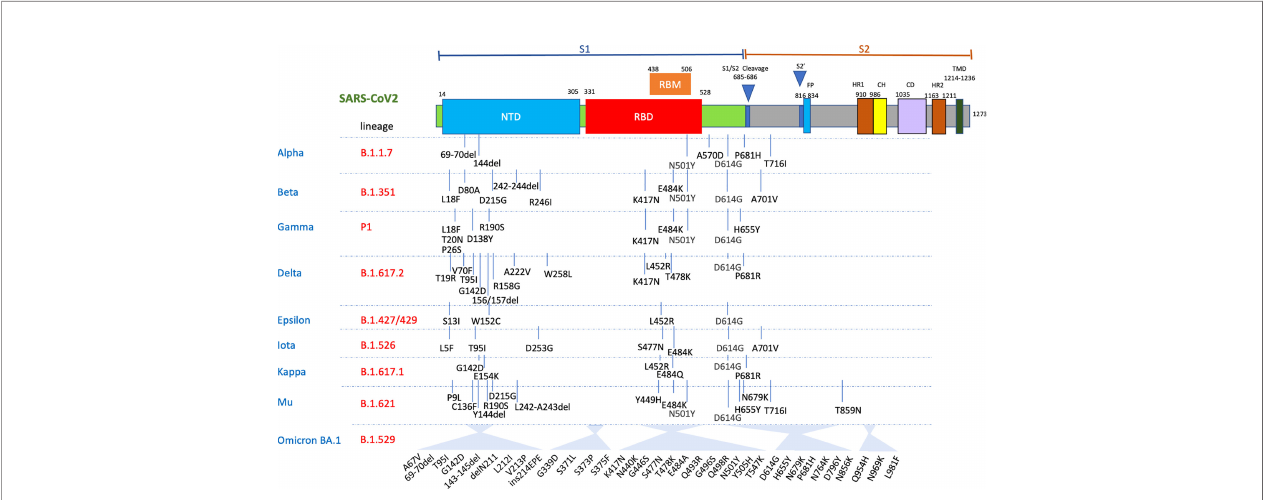
FIGURE 2 | Mutations in the viral spike identi fi ed in Alpha, Beta, Delta, Gamma, Mu and Omicron BA.1 SARS-CoV-2 variants showing the signi fi cant clusters of changes in both the N-terminal domain (NTD) and RBD. FP, fusion peptide; HR1, heptad repeat 1; CH, central helix; CD, connector domain; HR2, heptad repeat 2; TMD, transmembrane